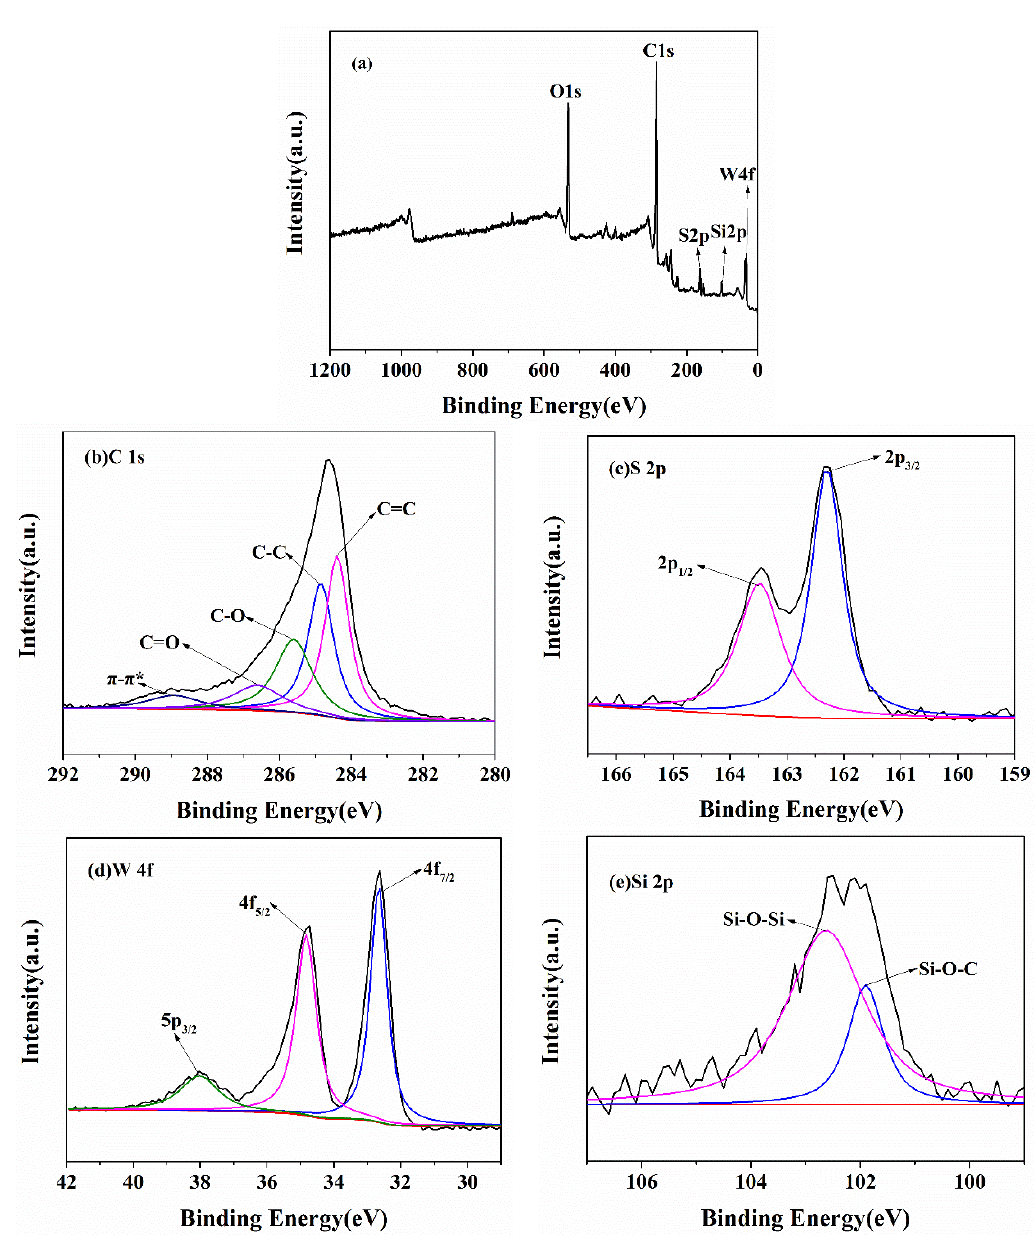
Figure 3. XPS spectra of ( a ) NH 2 -rGO/WS 2 , ( b ) C 1s, ( c ) S 2p, ( d ) W 4f and ( e ) Si 2p of NH 2 -rGO/WS 2 .